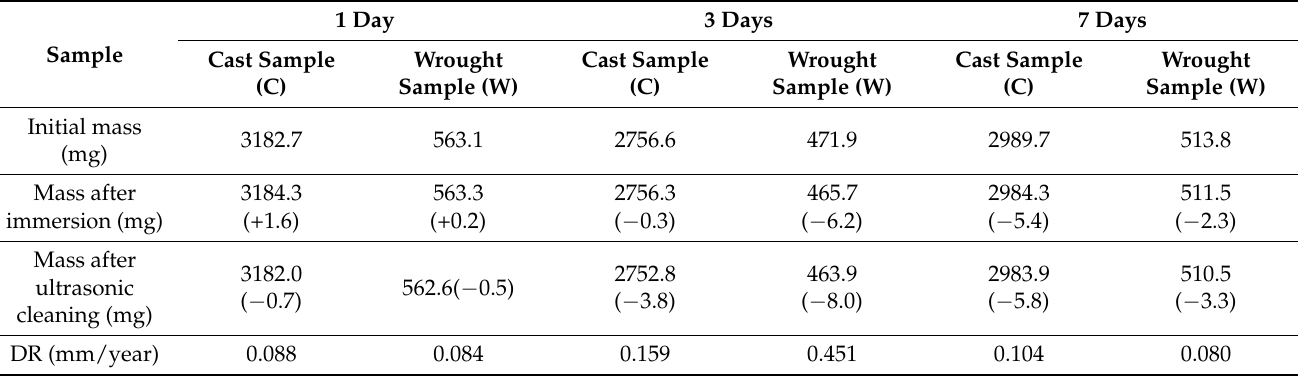
Table 2. The results of the masses of the experimental samples after 1, 3, and 7 days of immersion in Ringer’s solution (five repetitive mass determinations were done on the same sample) and the corresponding degradation